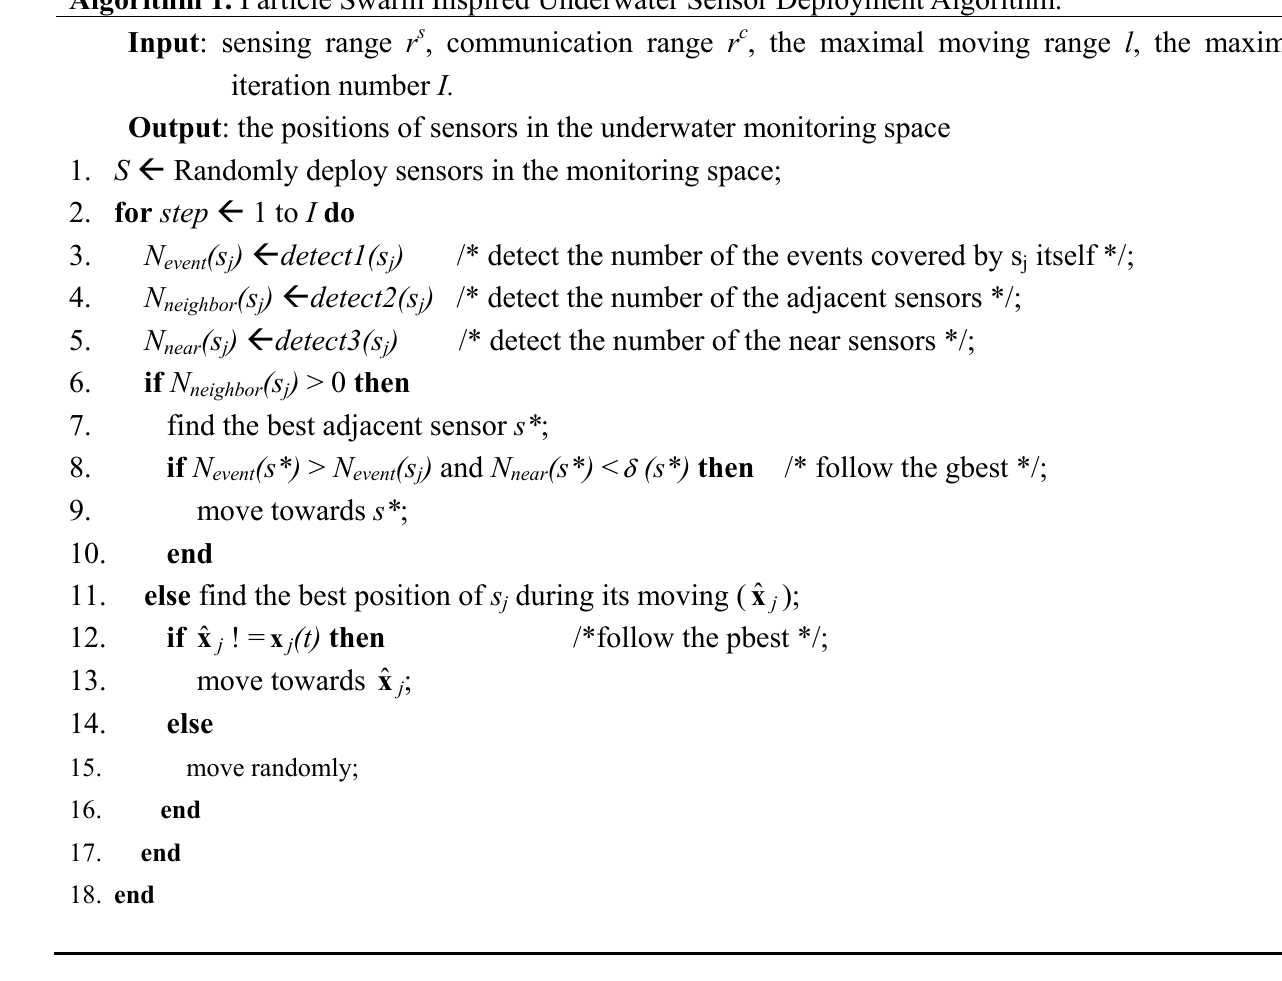
Algorithm 1. Particle Swarm Inspired Underwater Sensor Deployment